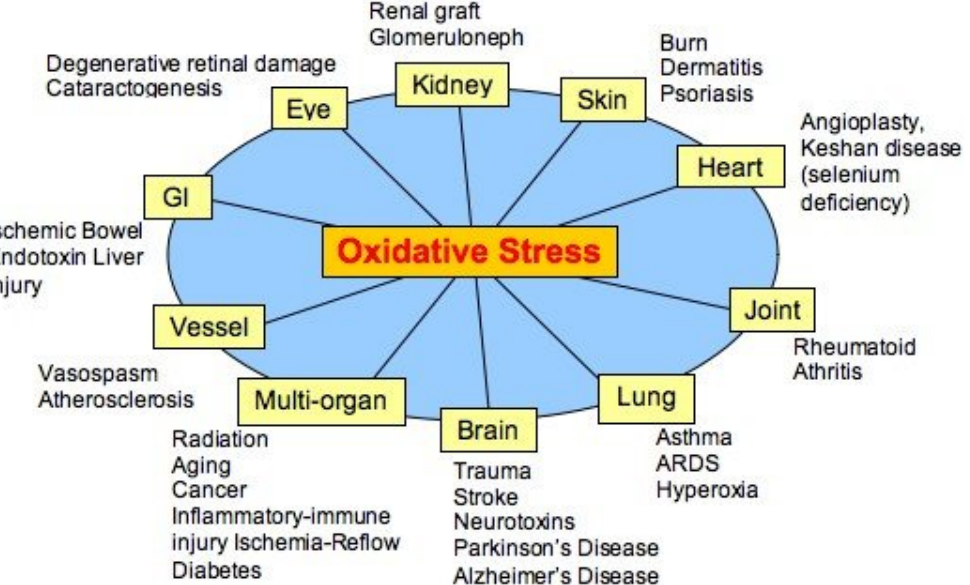
Figure 1. Alleged diseases linked to oxidative stress (modified from [6] ).